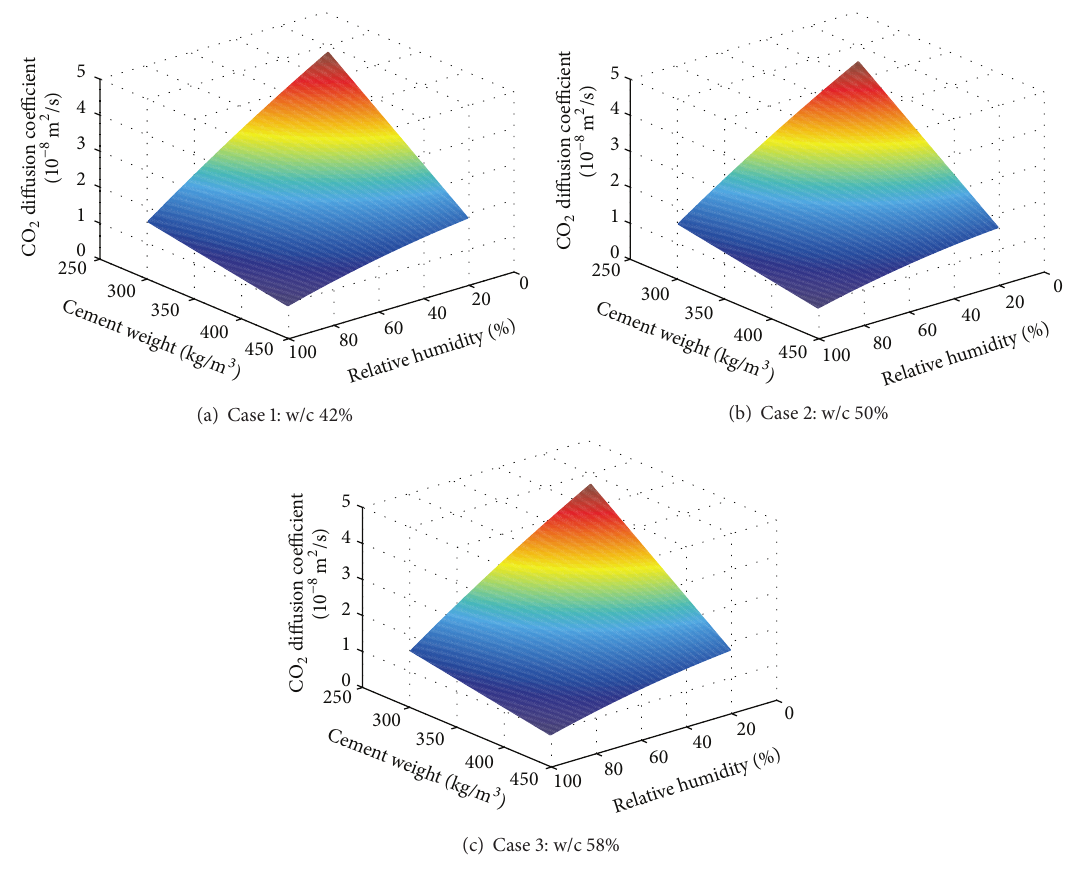
Figure 5: Diffusion coefficient contour with cement content and relative